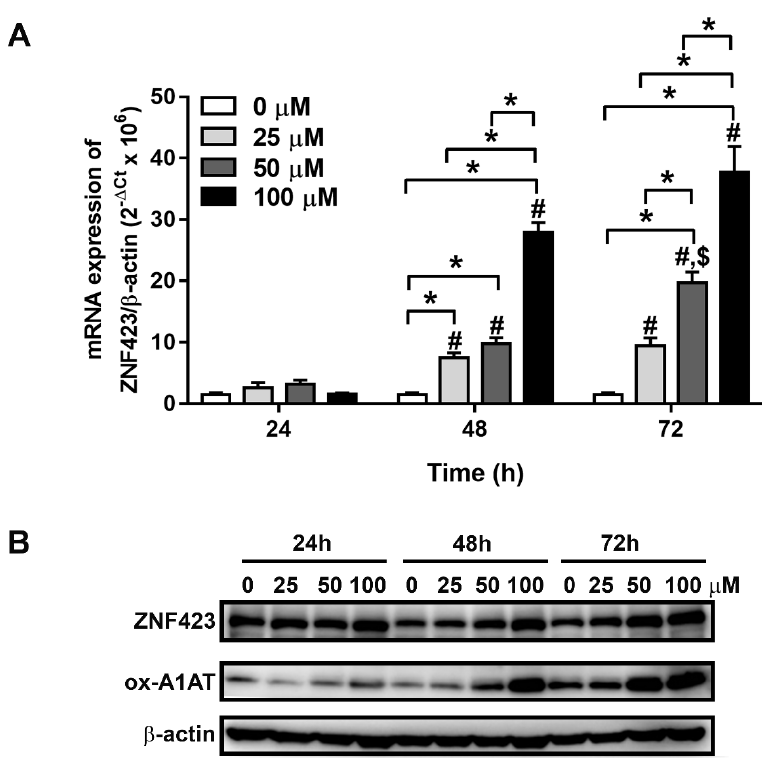
Figure 2. ( A ) ZNF423 mRNA expression levels and ( B ) protein expressions of ZNF423 (~100 kDa) and ox-A1AT (~52 kDa) in an immortalized cholangiocyte cell line (MMNK1) cells after treatment with various concentrations of H 2 O 2 (0, 25, 50 and 100 µ M for 24, 48 and 72 h). Significance was calculated by ANOVA test (* represents p < 0.05, # represents p < 0.05 compared with 24 h and $ represents p < 0.05 compared with 48 h). The mRNA expression levels of ZNF423 were normalized by β -actin.